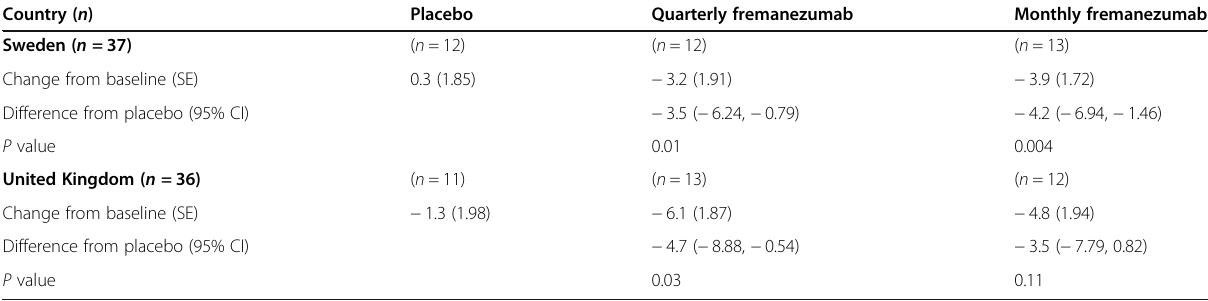
Table 1 Change From Baseline in the Monthly Average Number of Migraine Days During 12 Weeks of Double-blind Treatment (Primary Efficacy) in Individual Countries and Overall a